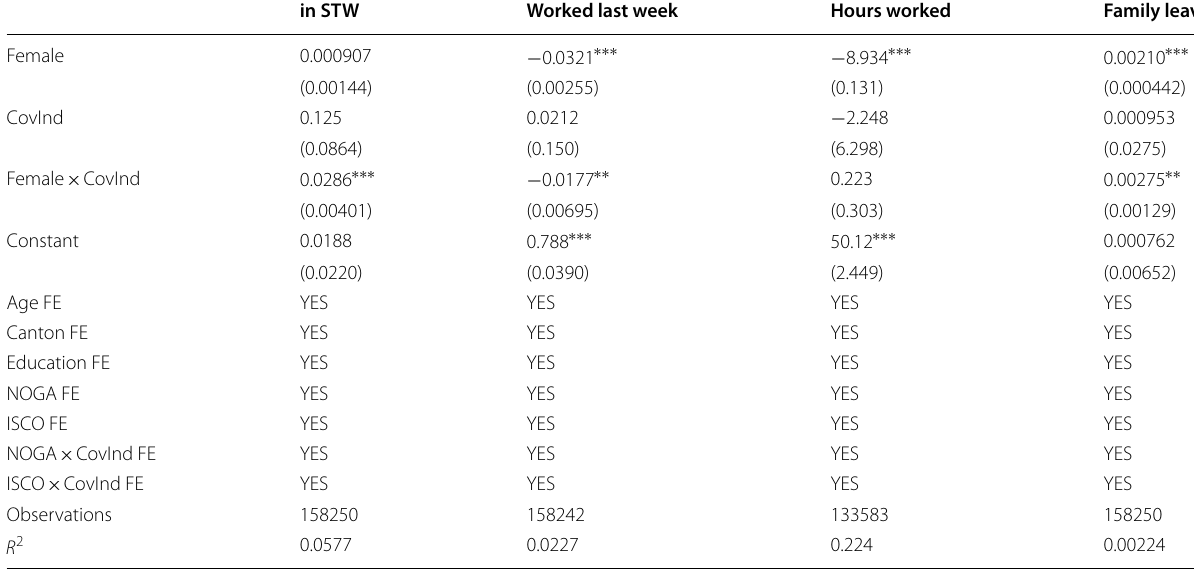
Table 14 Robustness: adding NOGA × CovInd and ISCO × CovInd